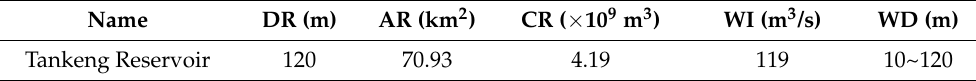
Table 2. The characteristic parameters of Tankeng